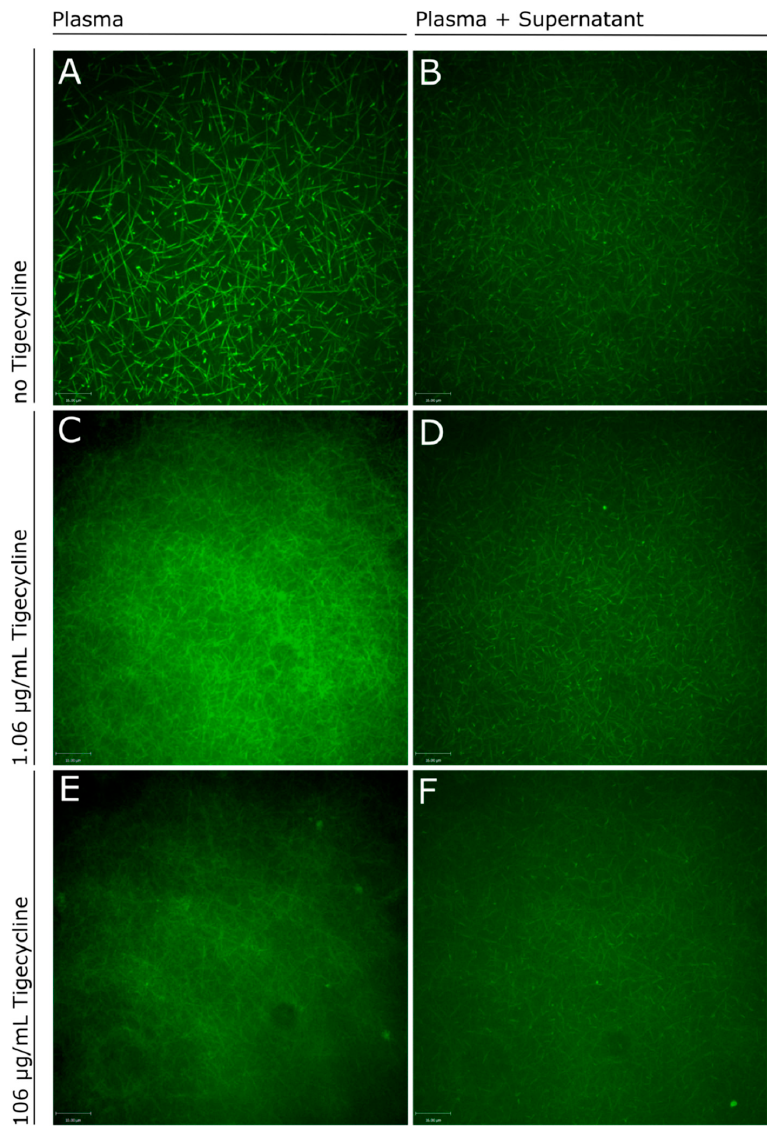
Figure 2. Confocal imaging of fibrin networks in plasma (left panel side) and plasma exchange experiments (right panel side). ( A ) shows the fibrin network in platelet-free plasma (PFP) of a healthy donor and ( B ) mixed with the supernatant of HepG2 cell culture experiments without the addition of tigecycline. Fibrin polymerization was compared to experiments applying increasing doses of tigecycline: PFP mixed with 1.06 µ g / mL ( C ) and 106 µ g / mL tigecycline ( E ) versus PFP mixed with conditioned supernatant of HepG2 after 24 h incubation in a 1:1 ratio with 1.06 µ g / mL ( D ) and 106 µ g / mL tigecycline ( F ). green = Fluorescein isothiocyanate (FITC)-labeled FXIIIa; PFP = platelet free